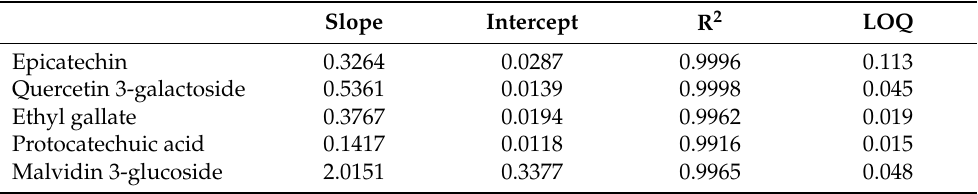
Table 1. Calibration curve parameters for the available